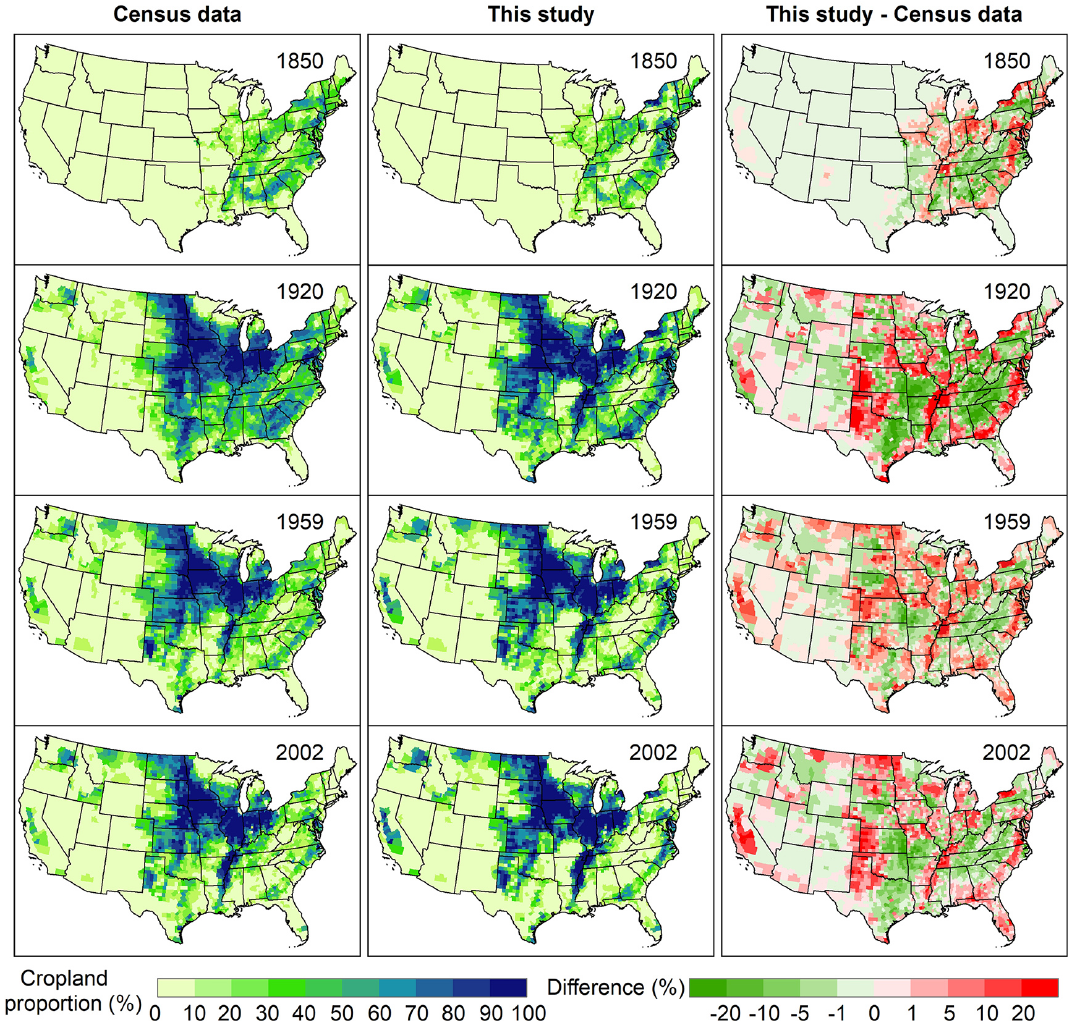
Figure 10. Spatial comparison of county-level cropland proportion between our reconstruction and census data in 1850, 1920, 1959, and 2002. First column: cropland proportion from census data, second column: cropland proportion derived from this study, and third column: cropland proportion difference between this study and census